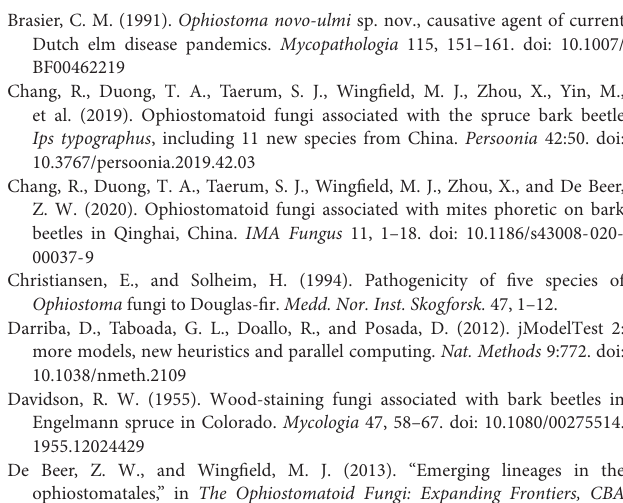
Supplementary Figure 2 | Phylogram of Ophiostoma piceae complex (including taxons 1 and 2) based on TEF1- α sequence data. Bold branches indicate posterior probability values ≥ 0.9. The MP/ML bootstrap support values ≥ 70% are recorded at the nodes. H, ex-holotype; P, ex-paratype; T, ex-type isolates. Supplementary Figure 3 | Phylogram of Ophiostoma piceae complex (including taxons 1 and 2) based on CAL sequence data. Bold branches indicate posterior probability values ≥ 0.9. The MP/ML bootstrap support values ≥ 70% are recorded at the nodes. H, ex-holotype; P, ex-paratype; T, ex-type isolates. Supplementary Figure 4 | Phylogram of Lineage A (including taxons 3 and 4) based on ITS sequence data. Bold branches indicate posterior probability values ≥ 0.9. The MP/ML bootstrap support values ≥ 70% are recorded at the nodes. T, ex-type isolates. Supplementary Figure 5 | Phylogram of Lineage A (including taxons 3 and 4) based on Tub2 sequence data. Bold branches indicate posterior probability values ≥ 0.9. The MP/ML bootstrap support values ≥ 70% are recorded at the nodes. T, ex-type isolates. Supplementary Figure 6 | Phylogram of Ophiostoma ips complex (including taxon 5) based on combined (ITS + Tub2) sequence data. Bold branches indicate posterior probability values ≥ 0.9. The MP/ML bootstrap support values ≥ 70% are recorded at the nodes. T, ex-type isolates. Supplementary Figure 7 | Phylogram of Ophiostoma ips complex (including taxon 5) based on ITS sequence data. Bold branches indicate posterior probability values ≥ 0.9. The MP/ML bootstrap support values ≥ 70% are recorded at the nodes. T, ex-type isolates. Supplementary Figure 8 | Phylogram of Ophiostoma ips complex (including taxon 5) based on Tub2 sequence data. Bold branches indicate posterior probability values ≥ 0.9. The MP/ML bootstrap support values ≥ 70% are recorded at the nodes. T, ex-type isolates. Supplementary Figure 9 | Phylogram of G. cainii lineage (including taxons 6 and 7) based on Tub2 sequence data. Bold branches indicate posterior probability values ≥ 0.9. The MP/ML bootstrap support values ≥ 70% are recorded at the nodes. T, ex-type isolates. Supplementary Figure 10 | Phylogram of G. cainii lineage (including taxons 6 and 7) based on TEF1- α sequence data. Bold branches indicate posterior probability values ≥ 0.9. The MP/ML bootstrap support values ≥ 70% are recorded at the nodes. T, ex-type isolates. Supplementary Figure 11 | Phylogram of Endoconidiophora (including taxon 8) based on Tub1 sequence data. Bold branches indicate posterior probability values ≥ 0.9. The MP/ML bootstrap support values ≥ 70% are recorded at the nodes. D ., Dendroctonus ; I ., Ips ; L ., Larix ; P ., Picea